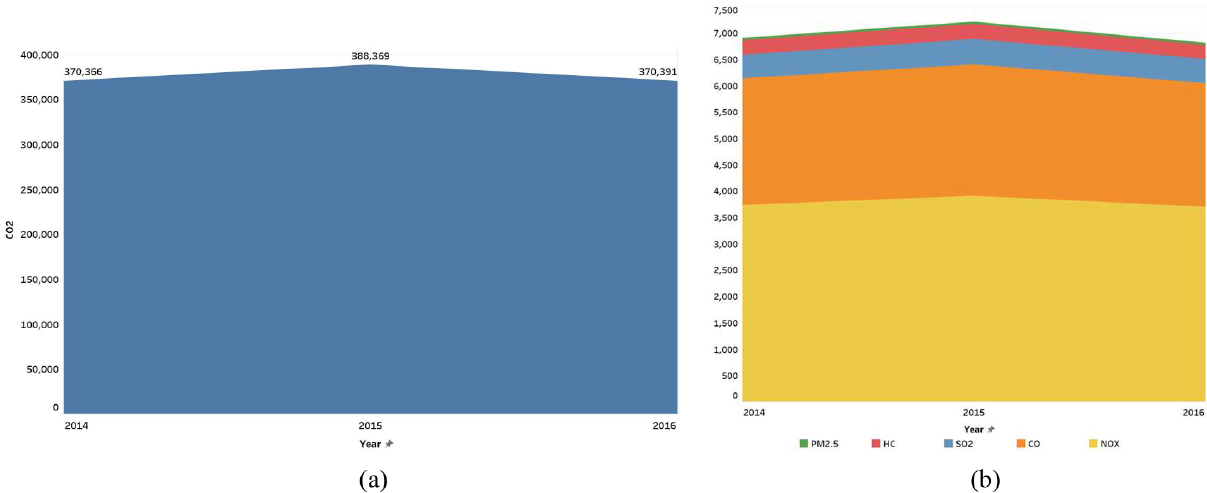
Figure 11. Changes in average emissions of six pollutant airlines before the CNG2020 strategy was proposed (tonnes). (a) Average overall airline emissions of CO 2 from 2014 to 2016. (b) Average overall airline emissions of the other five pollutants from 2014 to 2016.